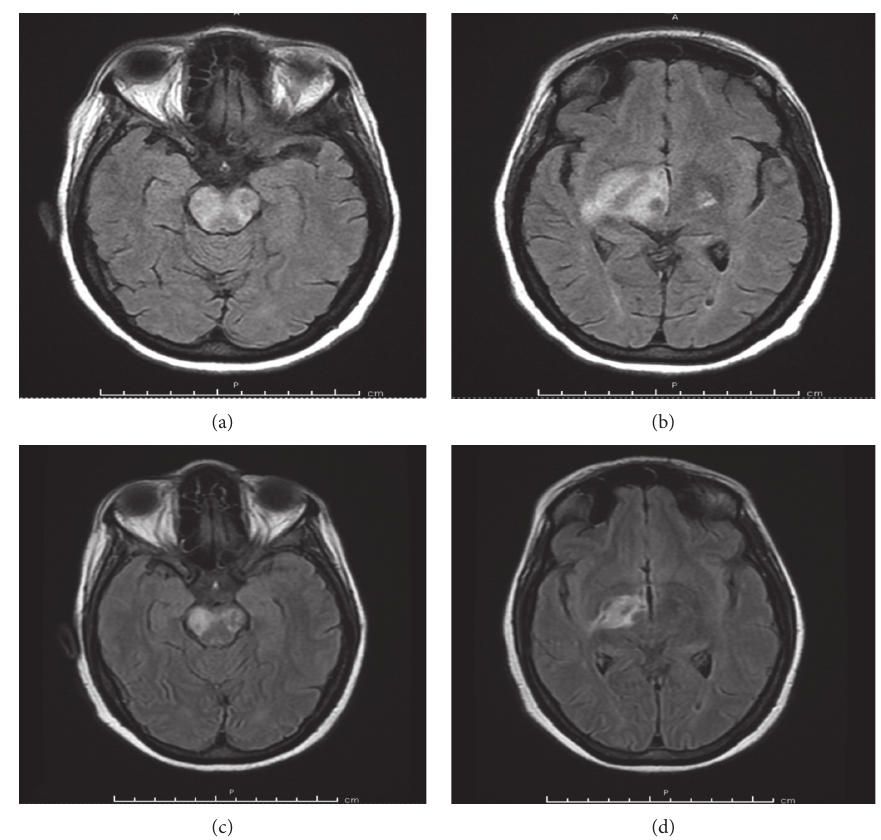
Figure 2: FLAIR brain MRI of a 52-year-old African American woman with active SLE demonstrating edematous lesion in the brainstem (a) extending to the basal ganglia (b) at initial hospital presentation in July 2019. Edema and lesion size decreased posttreatment with methylprednisolone, PLEX, and cyclophosphamide (c) and (d) FLAIR fluid-attenuated inversion